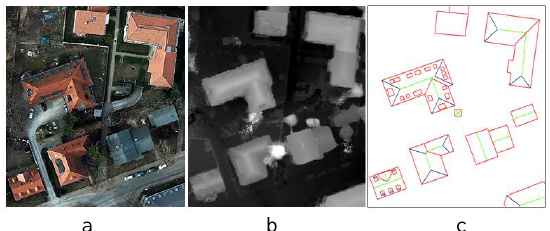
Figure 2. A sample of generated training data including a: the RGB image; b: the nDSM; c: